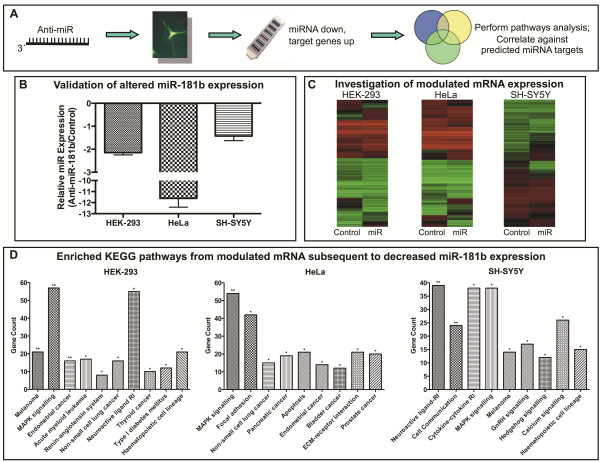
Biological processes affected by inhibition of endogenous miR-181b in cell culture in response to anti-miR-181b transfection. Panel A illustrates the experimental design for the identification of genes subject to de-repression of PTGS by decreased endogenous miRNA concentrations. Genes elevated in response to a fall in miRNA were utilised for pathways analysis and correlated against predicted miRNA targets. Panel B shows the decrease in miR-181b expression levels in comparison to controls for HEK-293, HeLa and SH-SY5Y cell types. Panel C shows a clustered-by-gene heat map from whole genome expression microarray data from each cell model, with n=2 per condition. Panel D shows the significantly enriched KEGG pathways for each cell type in response to decreased intracellular miR-181b levels.